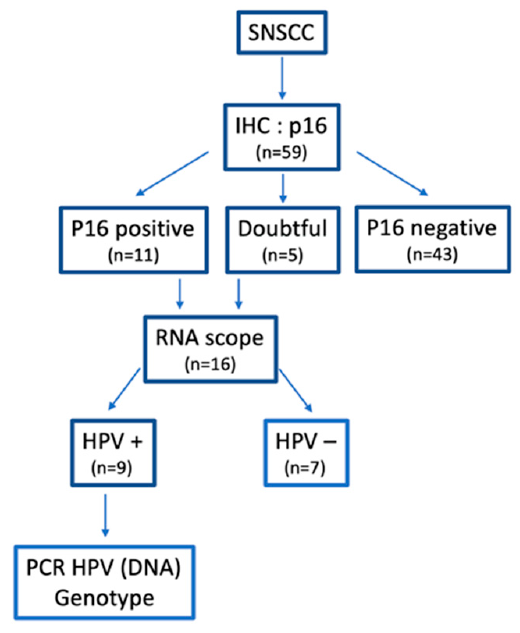
Figure 2. HPV status characterization.